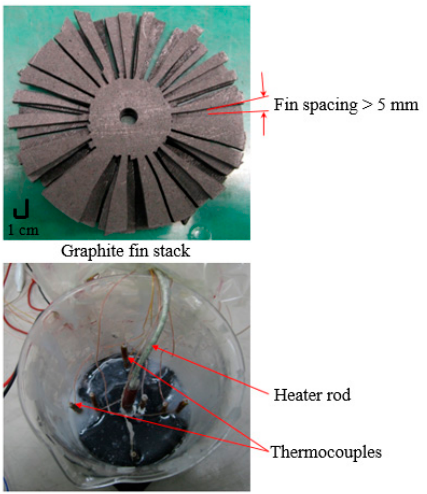
Figure 3. Carbon fin stack for PCM thermal conductivity enhancement. ( Top ) Fin stack; ( Bottom ) Experimental test set-up.